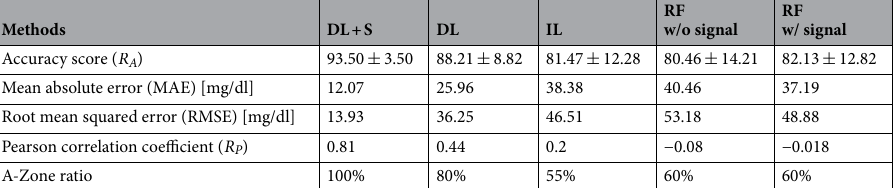
Table 3. Performance of models with 1st to 12th rounds as training and rounds 13, 14, 15 as testing (each paired with round 12). Our preliminary tests of personalized Random Forest (RF) model are also presented here. The A-Zone ratio is the ratio of data points located in the zone A of CEG plot, and R A , MAE, RMSE, and R p are defined in Eqs.4, 5, 6, and 7, respectively. Since each sample has its R A value, the average and standard deviation for each model were presented.